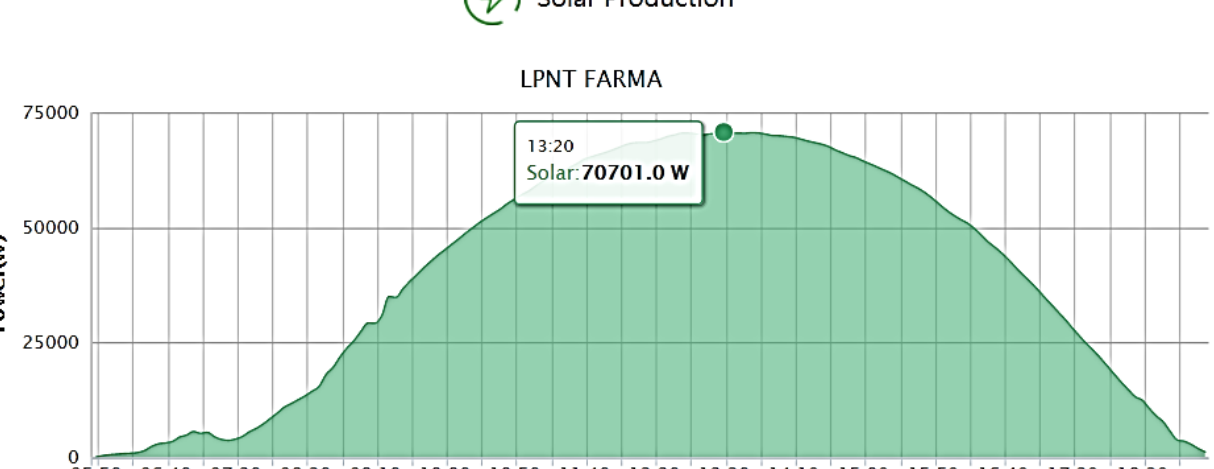
Figure 3. Total power generated by two micro-installations of 2 × 40 kWp on 11 April 2020.